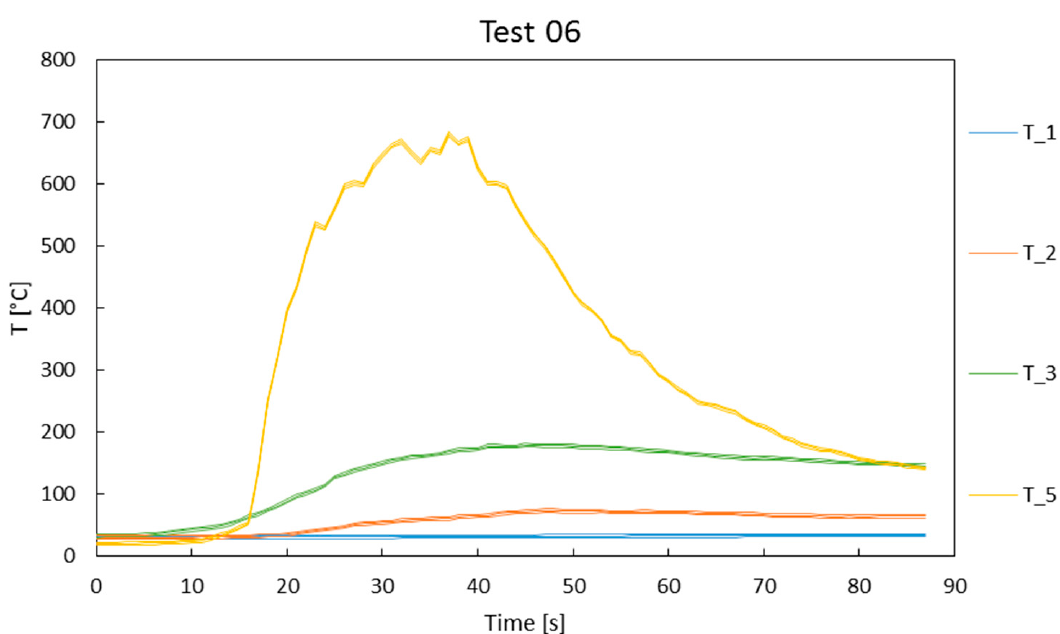
Figure 7. Evolution of temperatures in test 06.